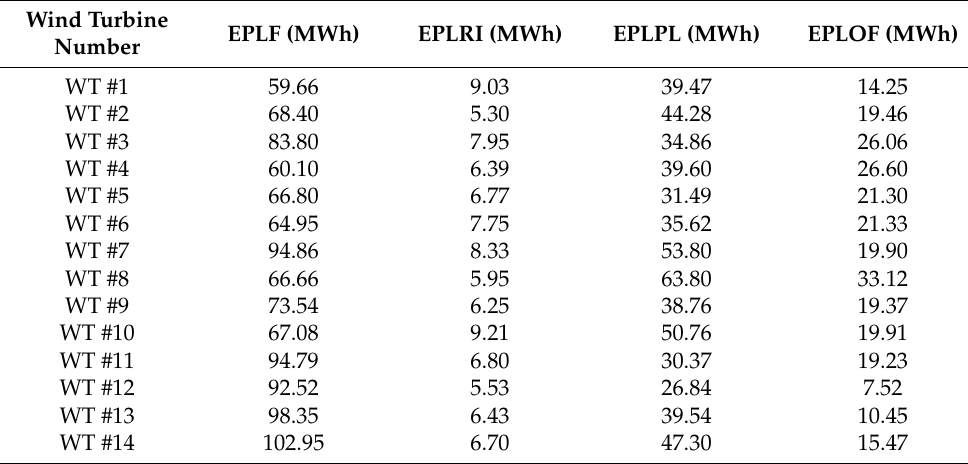
Table 2. The calculation results of energy production losses of wind turbines. Wind Turbine